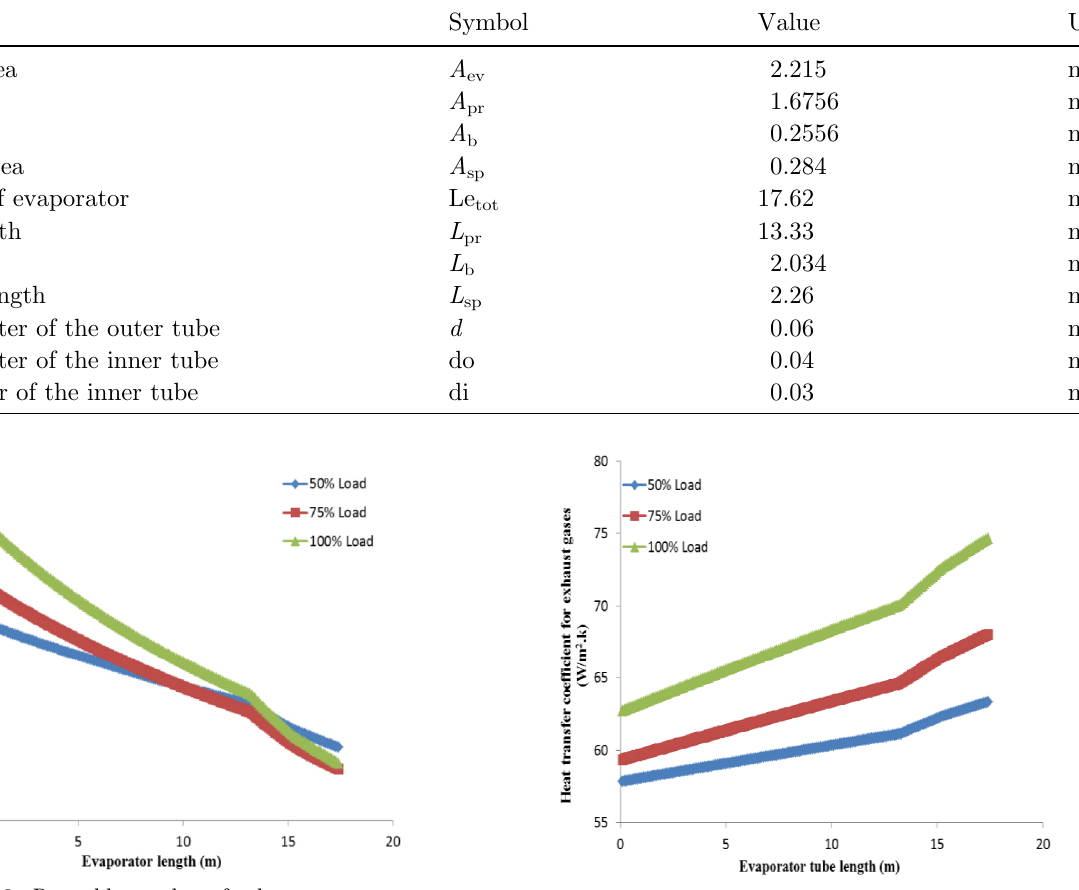
Fig. 3. Reynolds number of exhaust gas. Fig. 4. Heat transfer coef fi cient of exhaust gas.